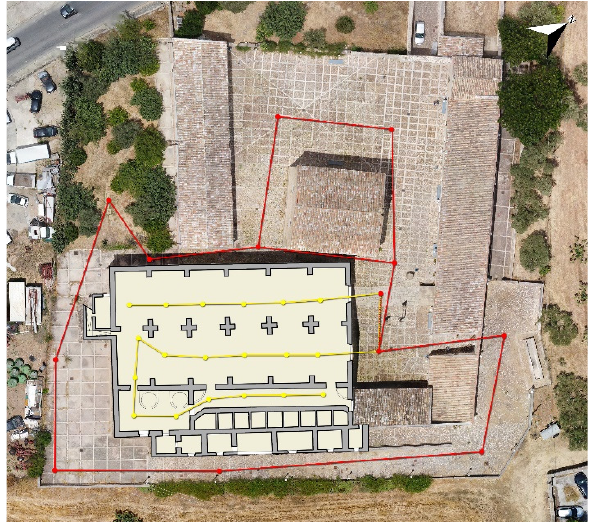
Figure 5 . External topographic traverse (in red) and laser scanner traverse (in